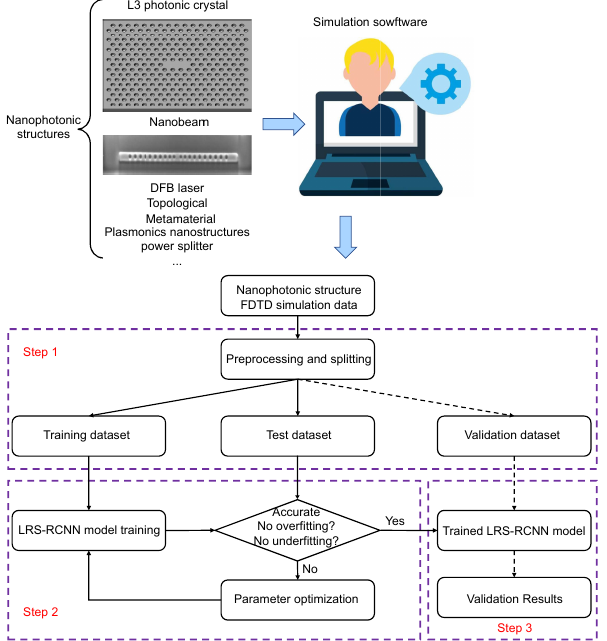
Figure 3. LRS-RCNN algorithm for modeling nanophotonic structures, implemented with a multi- step process: choose the desired structure, randomly fluctuate its design parameters and compute the optical properties in FDTD (pre-training steps), preprocess the dataset (step 1), train the model (step 2), and finally validate the model (step 3). Not shown in the diagram are the adaptive learning rates and L2 regularization, which are both core components of this